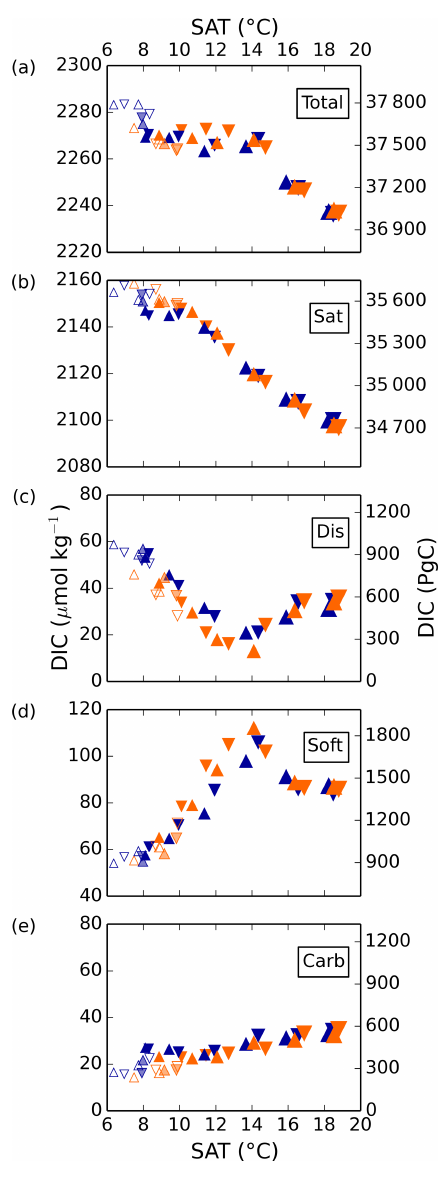
Figure 3. Global average DIC and separate components in simula- tions 1–36 as a function of globally averaged surface air tempera- ture (SAT). Orange and blue symbols represent high and low obliq- uity scenarios, respectively; triangles pointing upward and down- ward represent greater Northern and Southern hemisphere season- ality (precession 270 and 90 ◦ ); outlines are scenarios with LGM ice sheets; light shading indicates scenarios with LGM ice sheet topog- raphy but PI